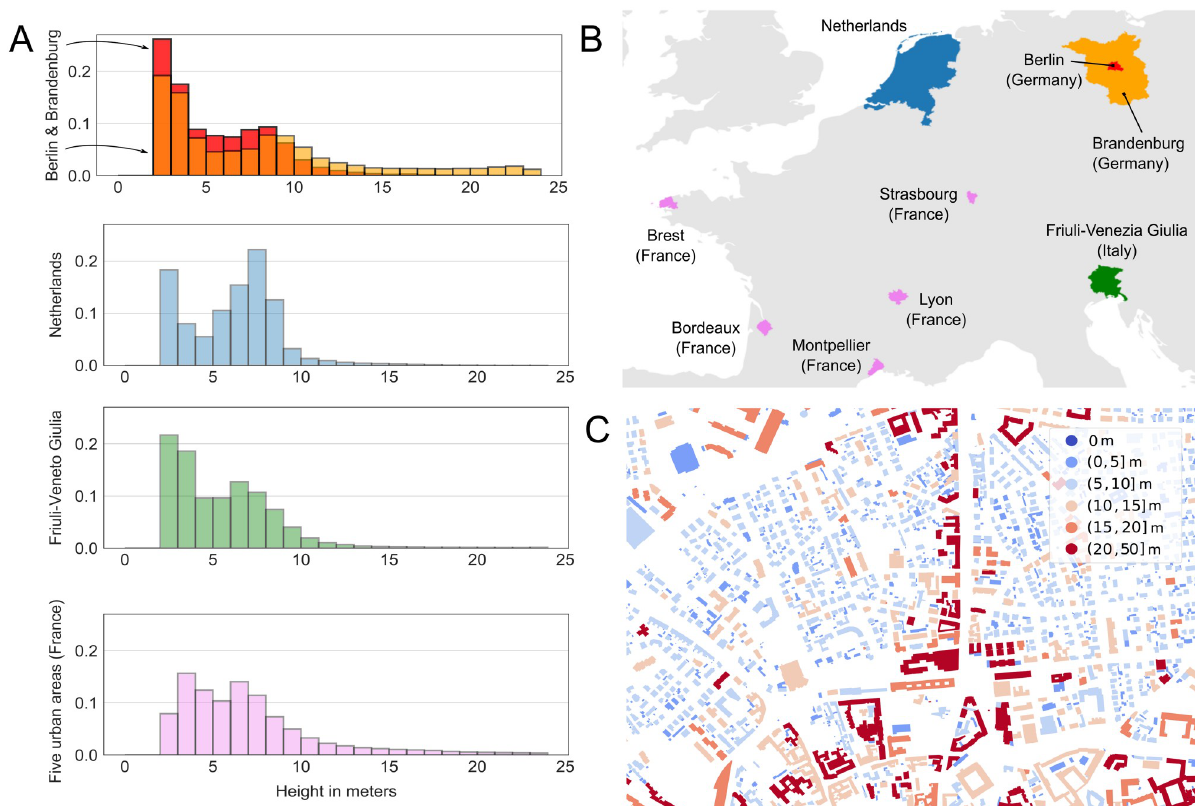
Fig 1. Building heights in the different geographical areas used in this study. ( A ) Height distributions for the state of Brandenburg in Germany, the Netherlands, the region of Friuli-Venezia Giulia in Italy and five French urban areas. These distributions correspond to the final dataset, after removing buildings with a height below 2 m and buildings with a footprint area below 10 m 2 , see S4 Appendix. ( B ) Location of the four areas representing Northern and Southern European regions, and urban and rural contexts. ( C ) Example of building heights in the city of Udine in Italy. This map shows a mid-size city with higher buildings in the historical center and along a main axis, and lower buildings in residential areas.